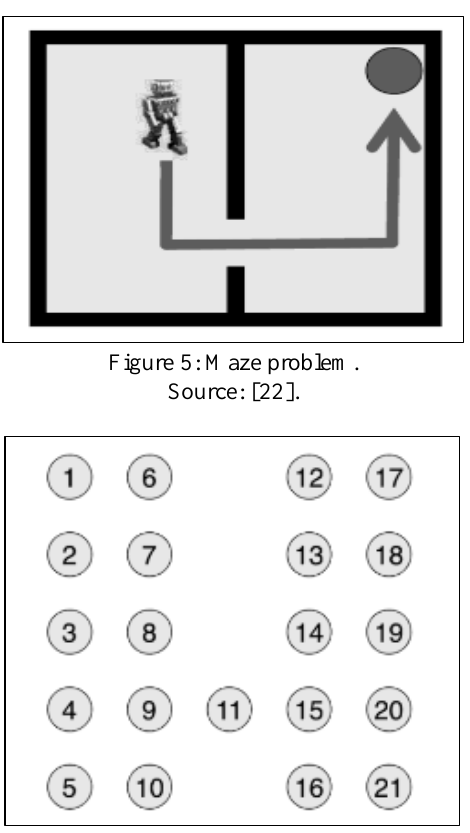
Figure 6: States of possible positions in the maze. Source: [22].